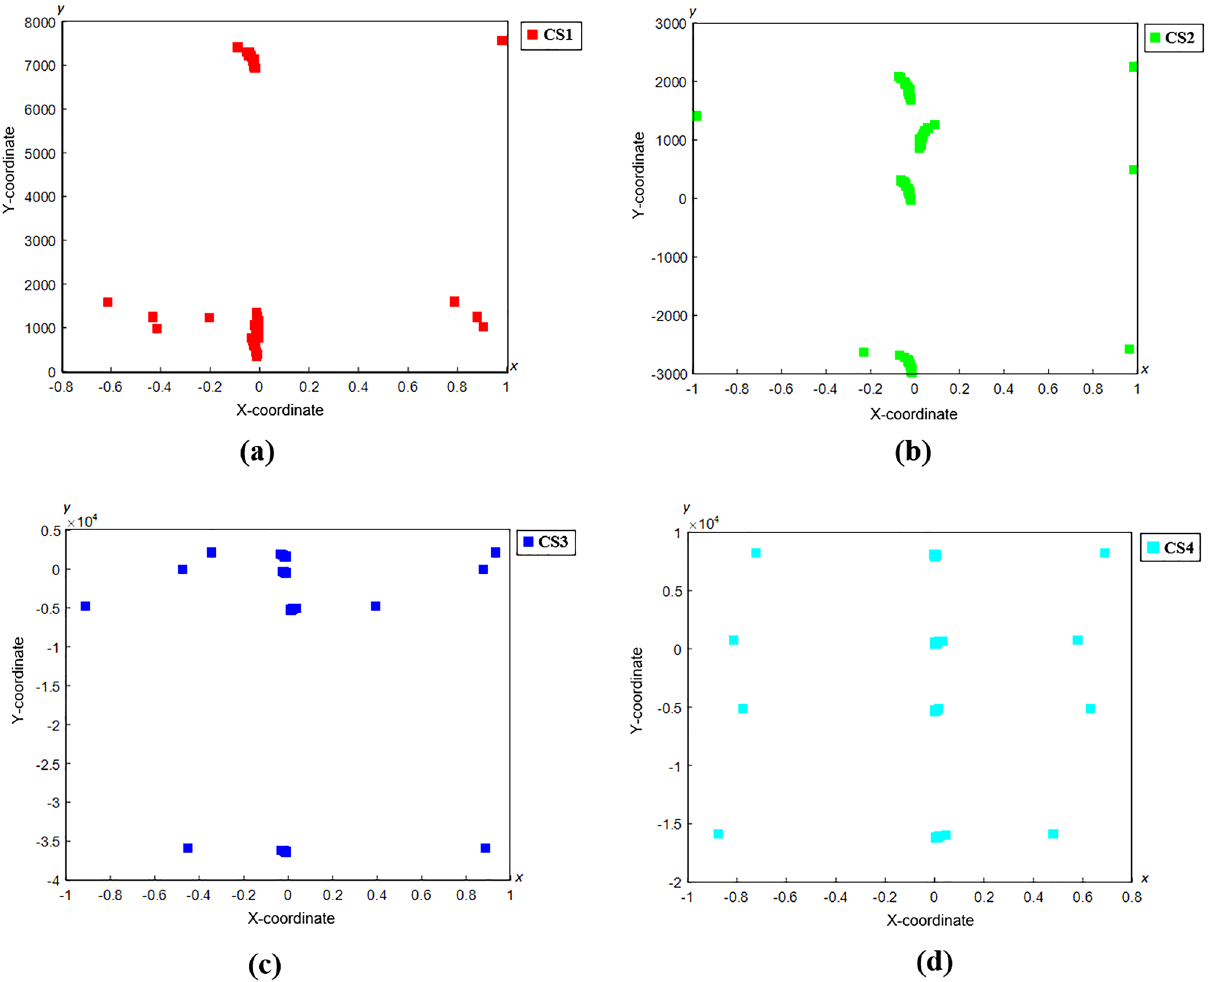
Figure 13. Coordinated FACS of Individual Counterfeit RM50 ( a ) Sample 1 (CS1), ( b ) Sample 2 (CS2), ( c ) Sample 3 (CS3) and ( d ) Sample 4 (CS4). This figure was generated using MATLAB version R2016a (Mathworks, Natick, MA; https:// www. mathw orks. https:// www. minit ab. com) to generate the PCA plots. The PCA decomposes the data matrix to PCs that describe the variations in the data set. The scores of the PCs represent the coordinates of the observations in the space